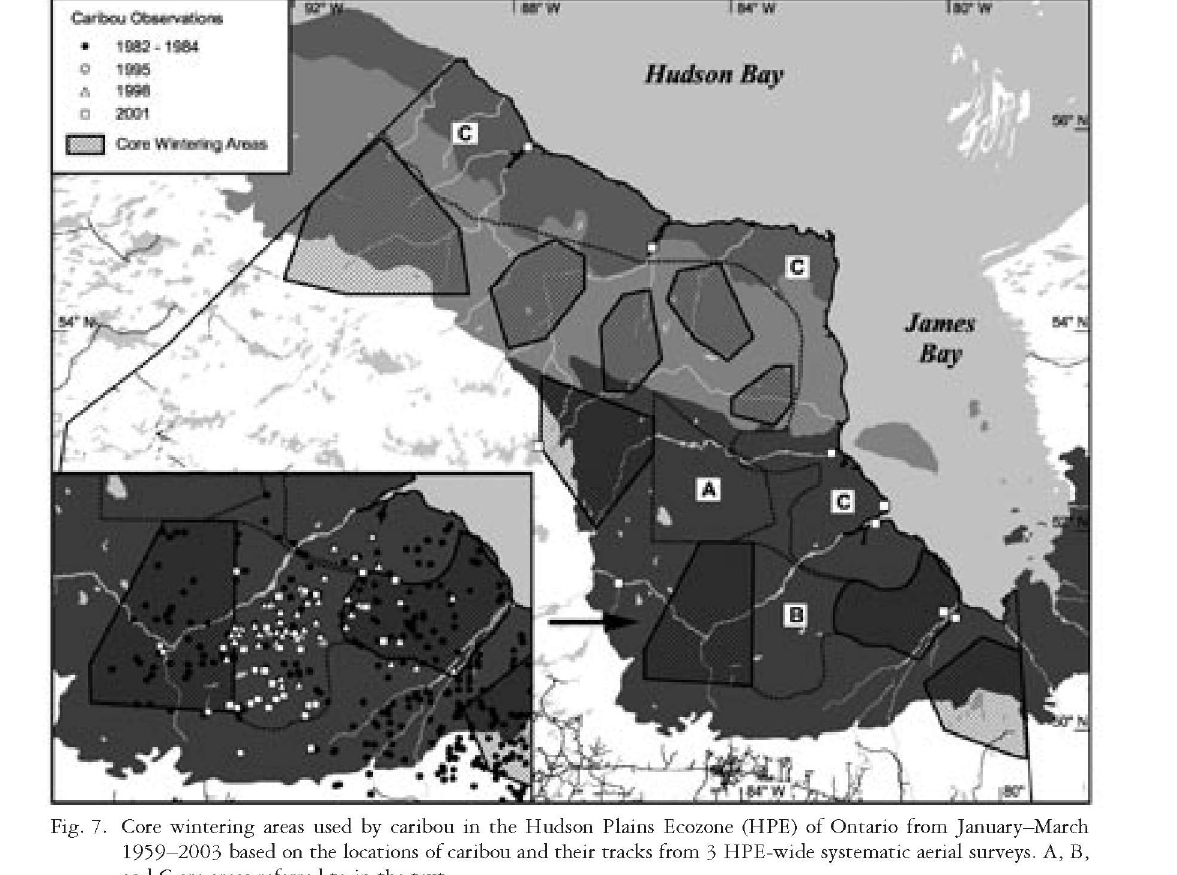
Fig. 7. Core wintering areas used by caribou in the Hudson Plains Ecozone (HPE) of Ontario from January—March 1959—2003 based on the locations of caribou and their tracks from 3 HPE-wide systematic aerial surveys. A, B, and C are areas referred to in the